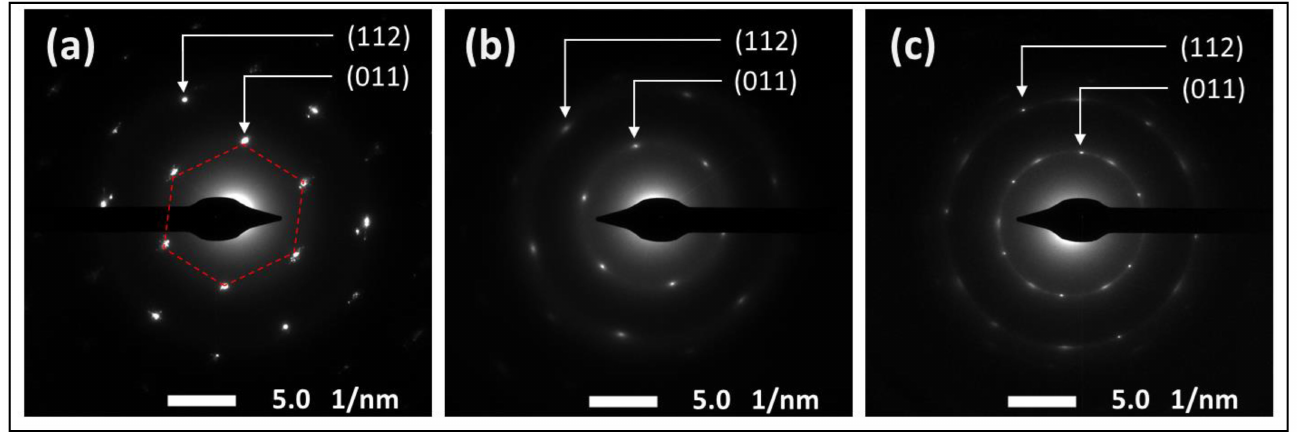
Figure 8. SAED diffraction patterns of ( a ) the pristine GO, ( b ) rGO-TEPA1 and ( c ) rGO-TEPA2.